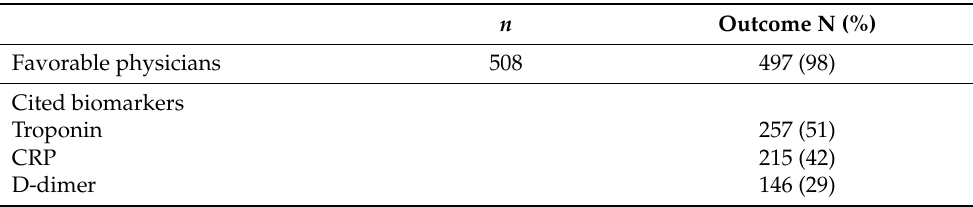
Table 2. Respondent specifications of biomarkers needed for obtaining fast results in physicians’ daily